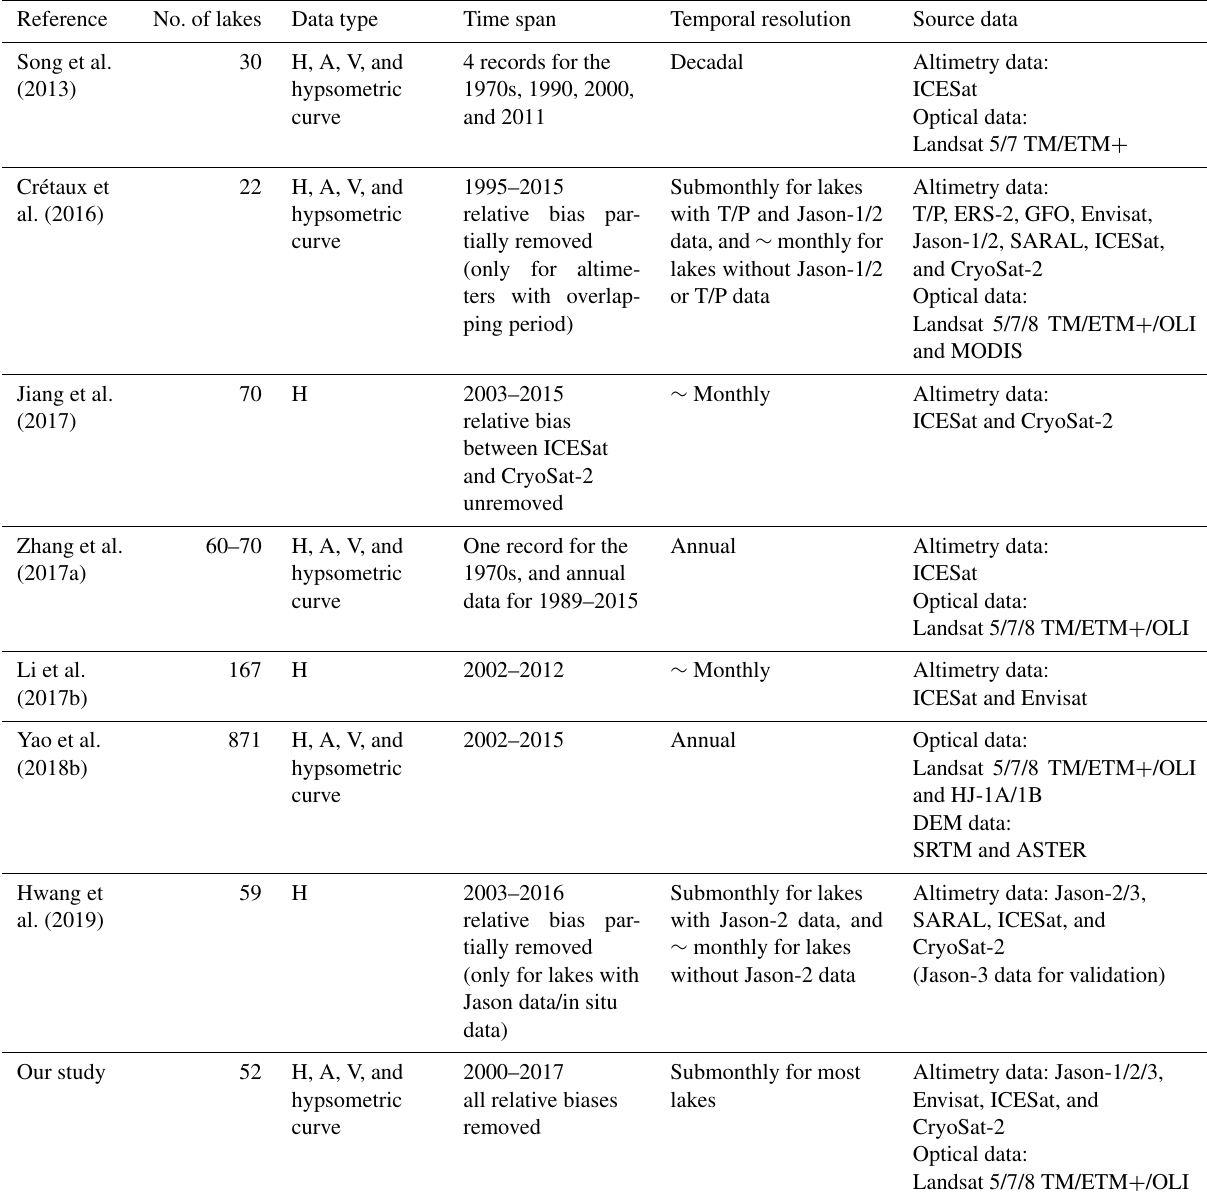
Table 1. Recent studies and data sets on TP lakes. H, A, and V in the table denote lake water level, area, and volume, respectively. Reference